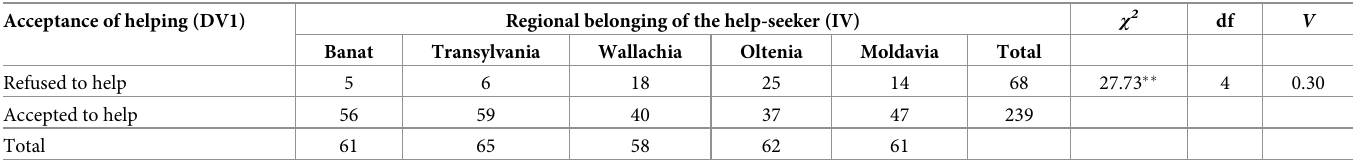
Table 1. Cross tabulation of regional belonging of help-seeker and acceptance of helping.